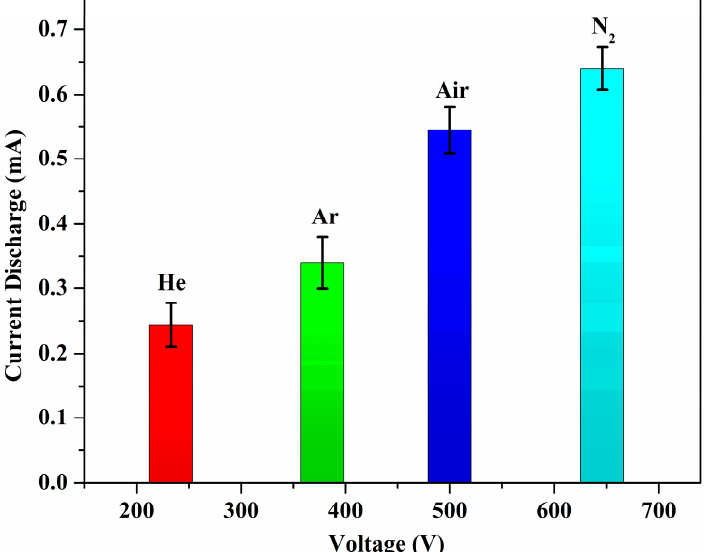
Figure 4. Breakdown signatures of various gases as tested. Reprinted with permission from [25]. The trend of breakdown voltages was similar to that observed by Modi et al.